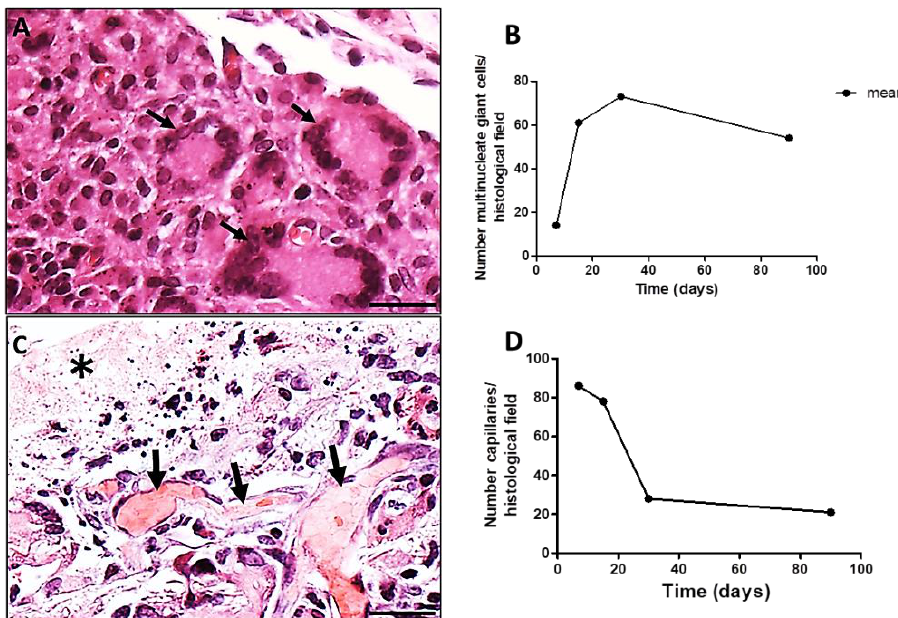
Figure 4. Histological sections of chronic inflammatory response induced by PLGA membranes. ( A ): Section showing the presence of LCs surrounding the chronic inflammation, 30 days PI. Scale